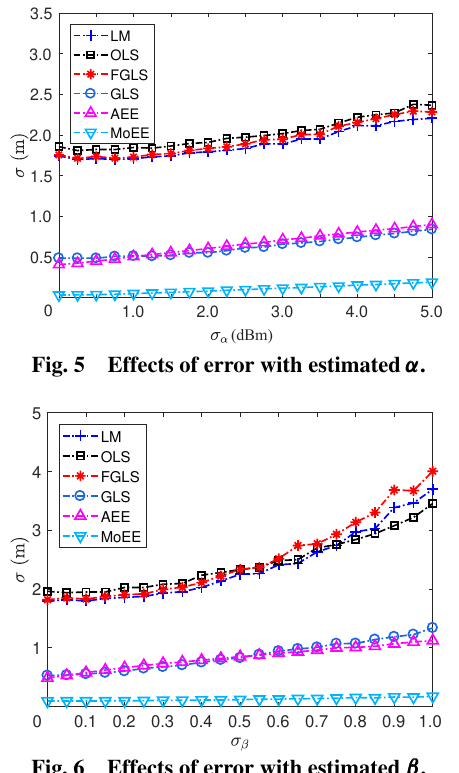
Fig. 4 Effects of measurement error with IID error.